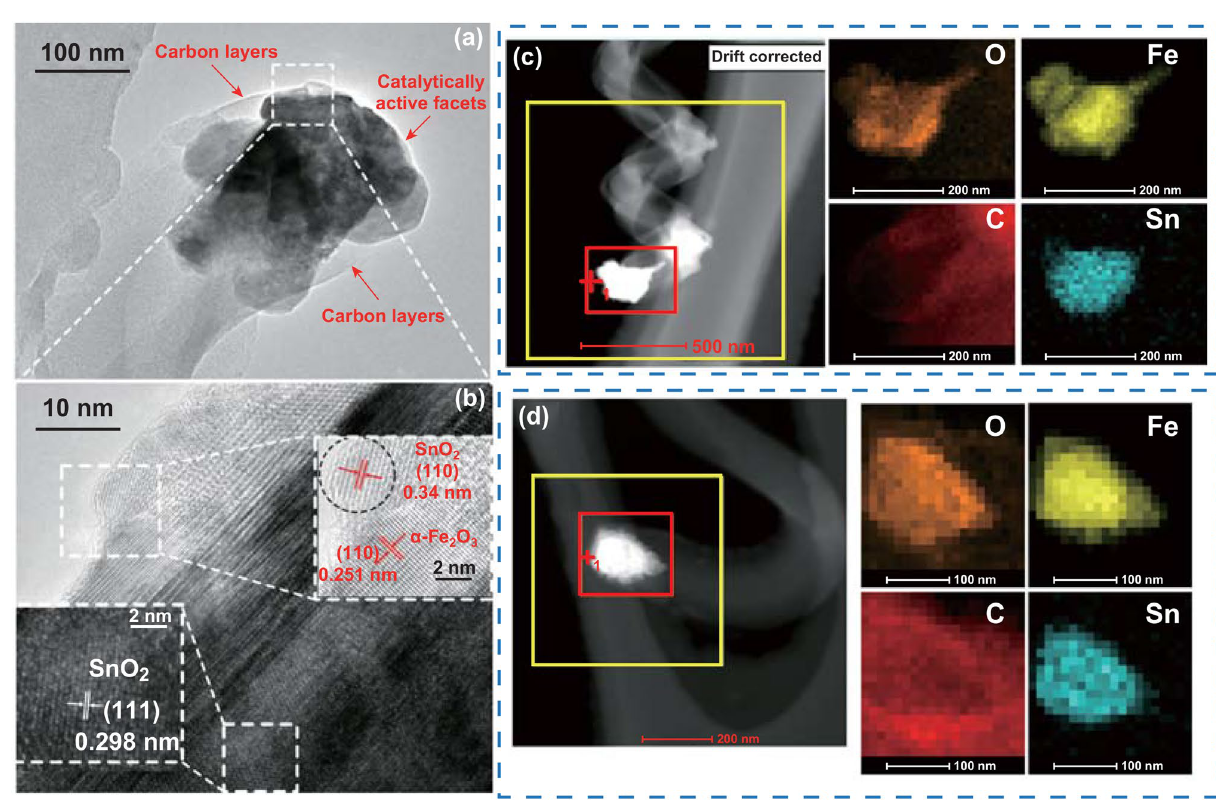
Fig. 6 a TEM image of the tip of an as-grown CNC synthesized by the Fe/Sn catalyst with molar ratio of 10:1; b HRTEM image of the part indicated by a dashed box in a ; c , d The elemental mapping of tip particles with Fe/Sn molar ratios of 10:1 and